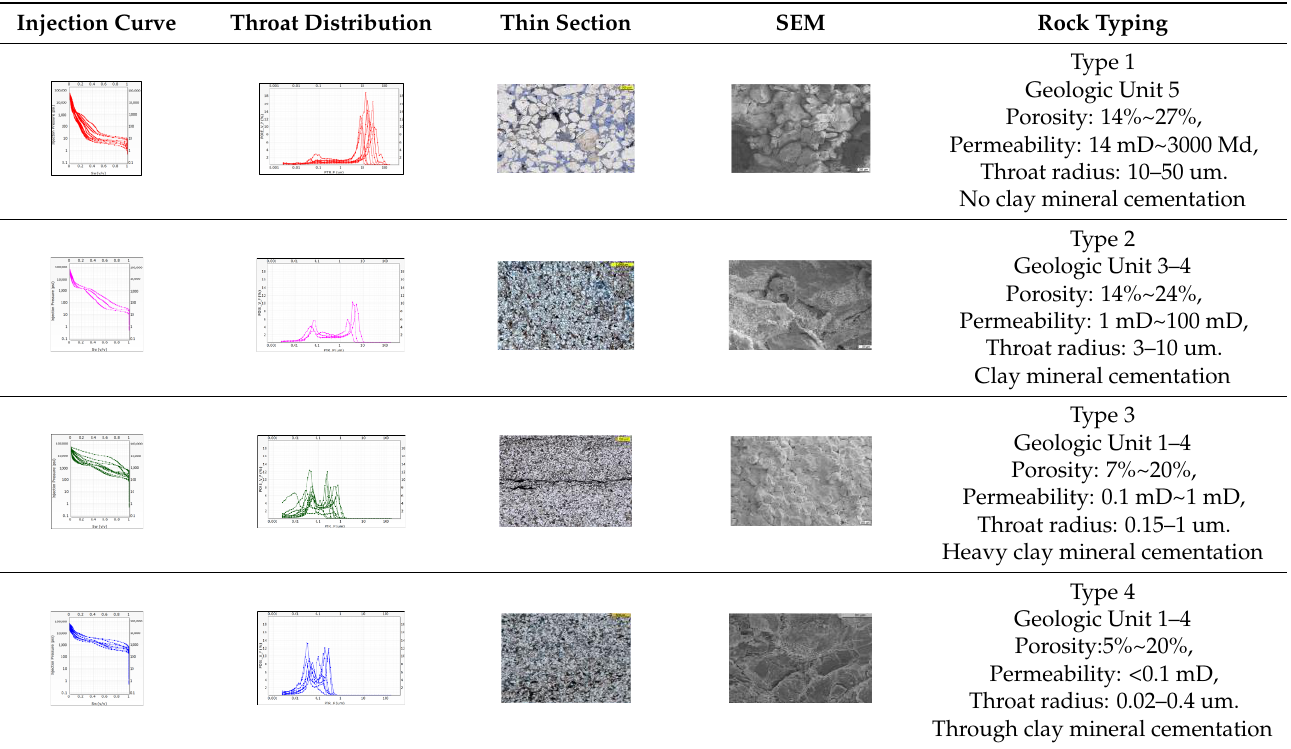
Table 2. Percentage of clay minerals in rock samples acquired from geological Unit 4 and Unit 5.